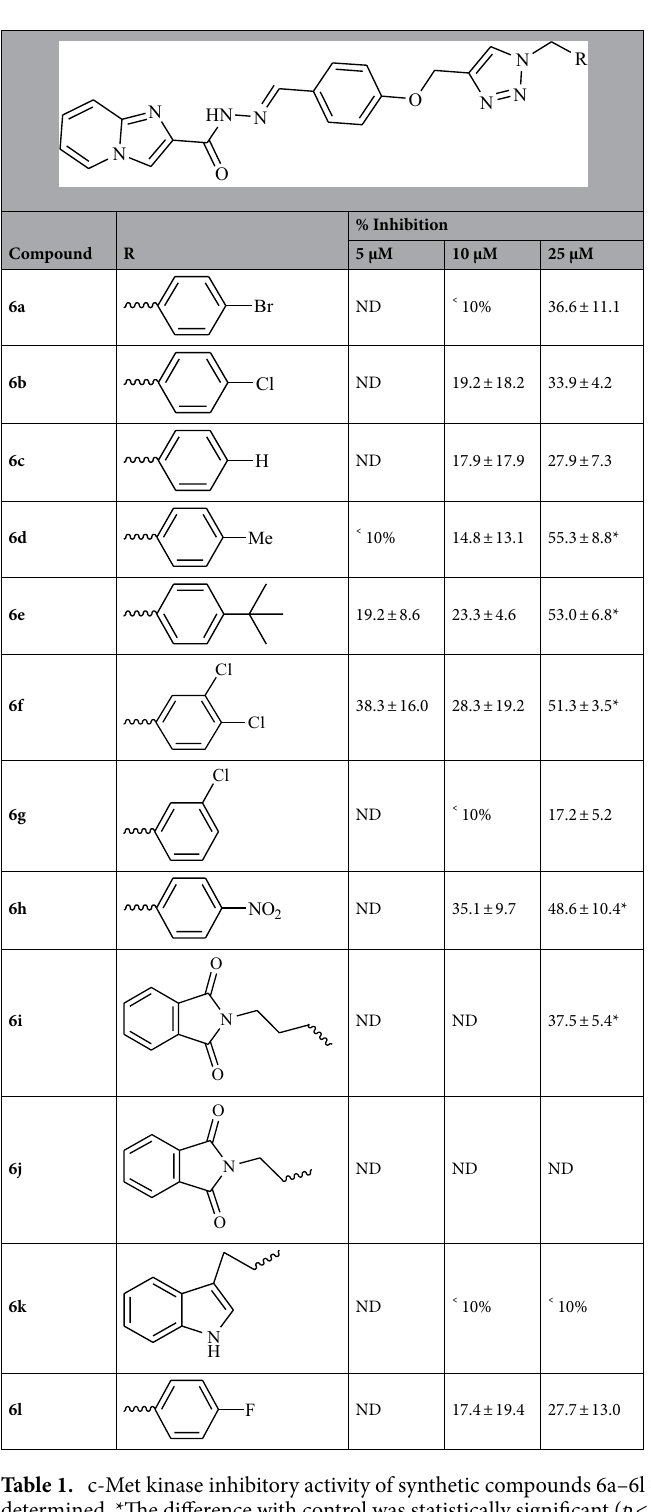
Table 1. c-Met kinase inhibitory activity of synthetic compounds 6a–6l determined by HTRF assay. ND not determined. *The difference with control was statistically significant ( p < 0.05). Values are the mean ± S.E.M. of 3–6 separate experiments. Crizotinib and cabozantinib were used as positive controls with IC 50 values 15.3 nM and 24.4 nM,